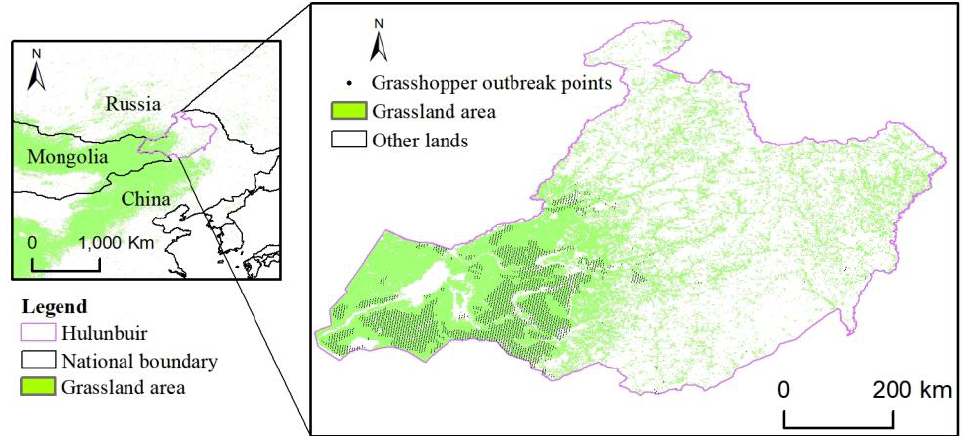
Figure 1. Location of the study area. Surveys of occurring species were conducted over the grassland area. Grasshopper outbreak points indicate areas that experienced grasshopper plagues between 2008 and 2020. The considered species include Oedaleus decorus asisticus , Bryodema luctuosum luctuosum , Calliptamus abbreviatus , Pararcypatera microptera meridionalis , Dasyhippus barbipes , Angaracris barabensis , and Angaracris rhodopa.